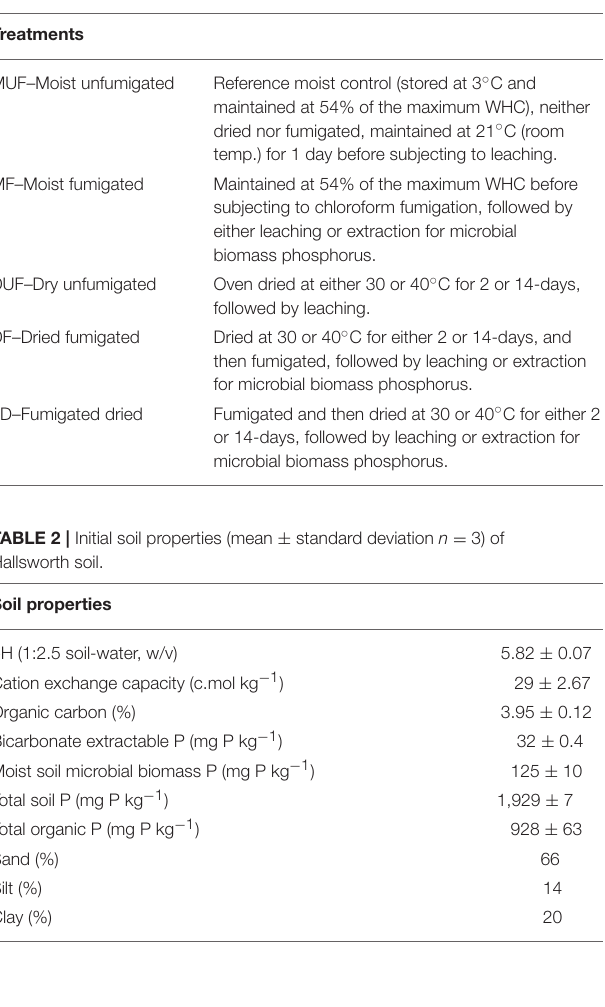
TABLE 1 | Types of treatments imposed (storage conditions, fumigation, and drying).